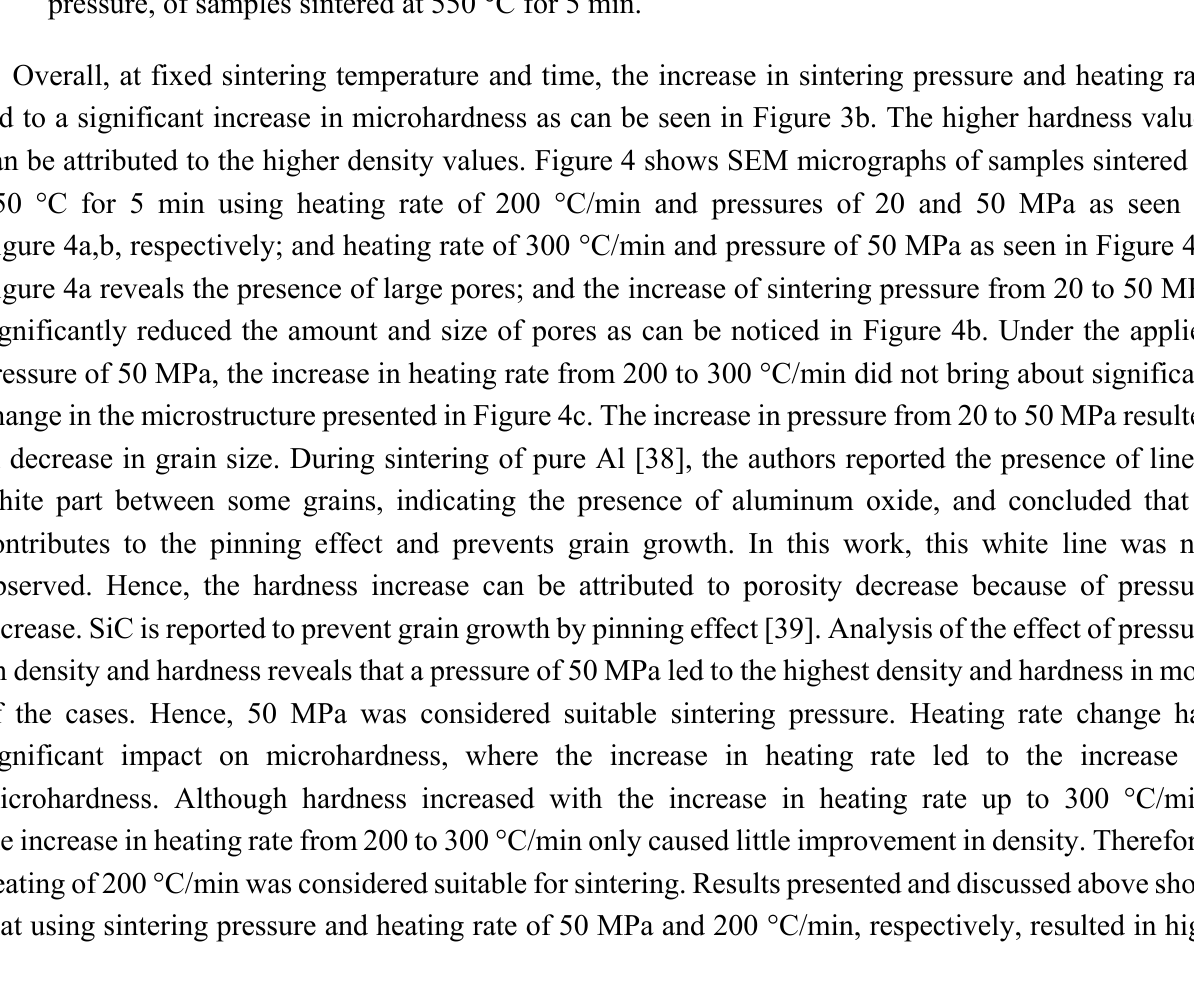
Figure 3. ( a ) Relative density and ( b ) microhardness, as function of heating rate and pressure, of samples sintered at 550 °C for 5